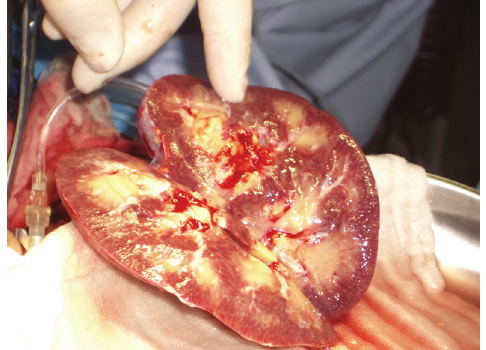
Figure 3: Macroscopic appearance of the rejected kidney during